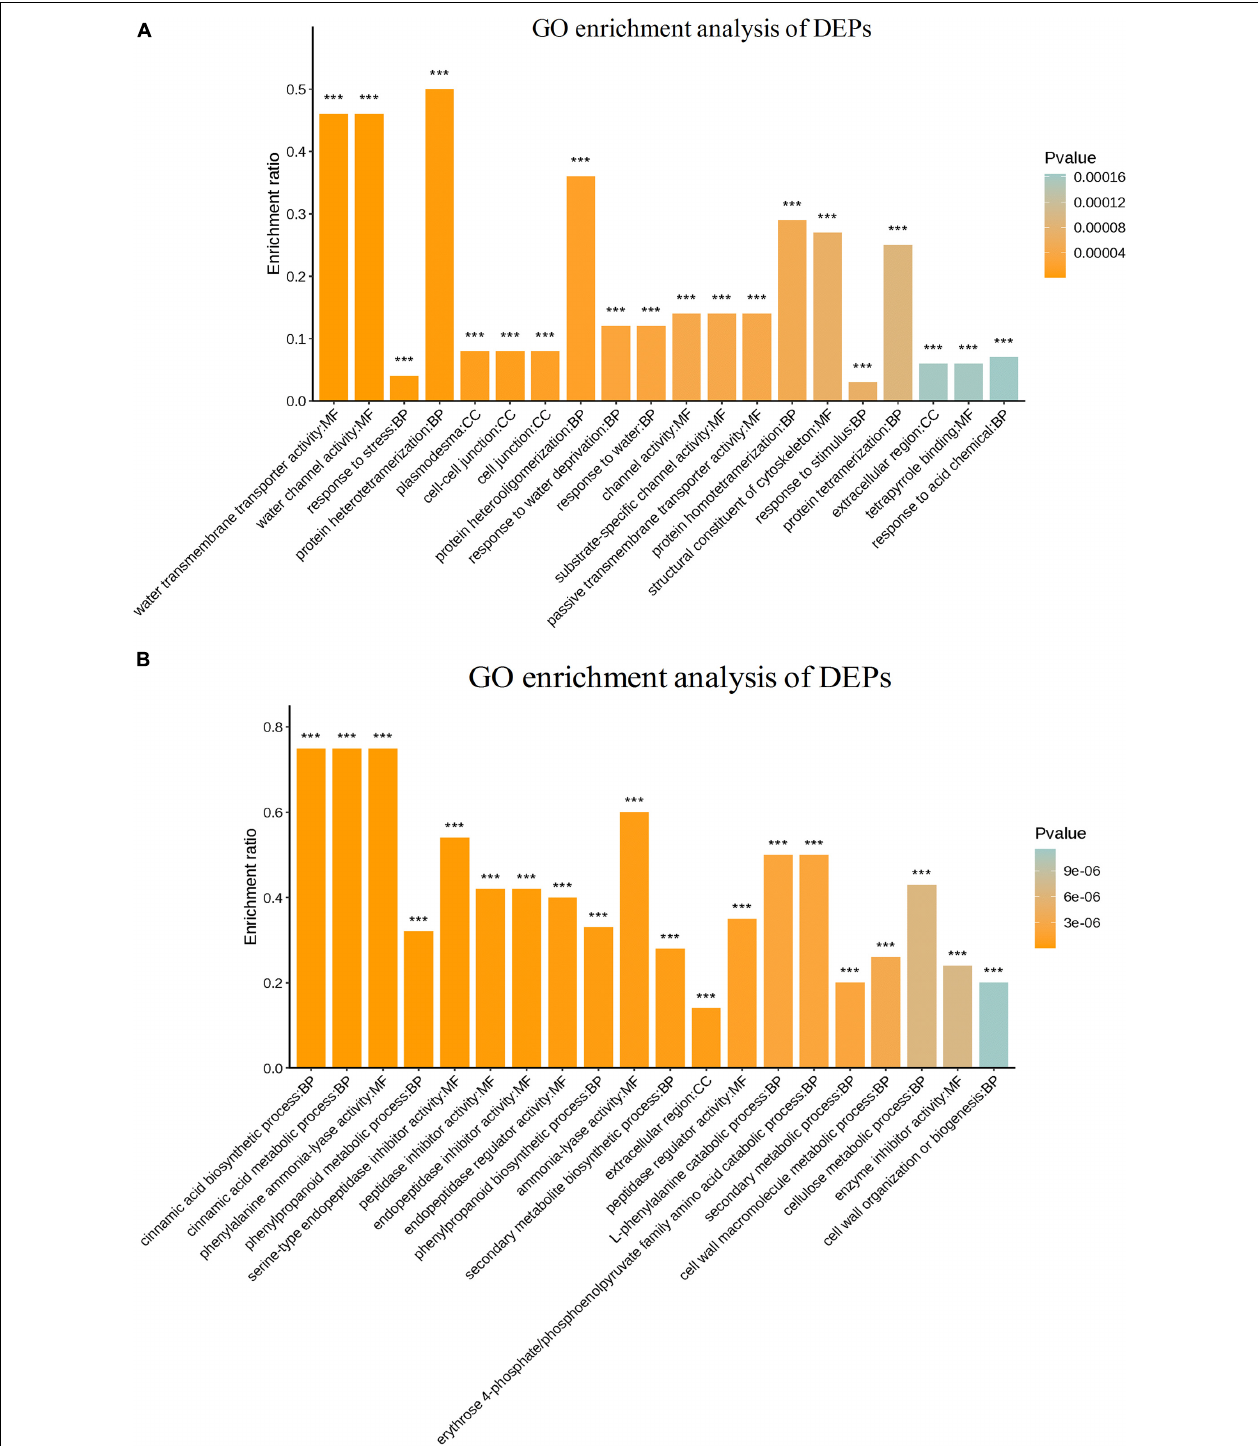
FIGURE 6 | GO enrichment of differentially expressed proteins in (A) GT11 and (B) B8 varieties of sugarcane inoculated with E. roggenkampii ED5 as compared to control. The abscissa represents the GO term and the ordinate represents the enrichment rate. The color gradient of the column represents the significance of enrichment, where p or FDR < 0.001 was marked as ***, p or FDR < 0.01 was marked as **, and p or FDR < 0.05 was marked as *.